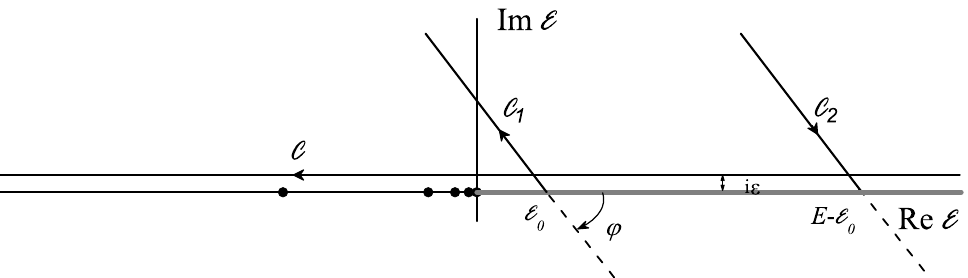
Figure 1. The path of integration of the convolution integral is the whole real E axis, from ∞ to − ∞ . The gray line is the unitarity branch cut for ˆ G e rotation of C , about some point E 0 on the positive real axis. The argument of ˆ G p the path C 2